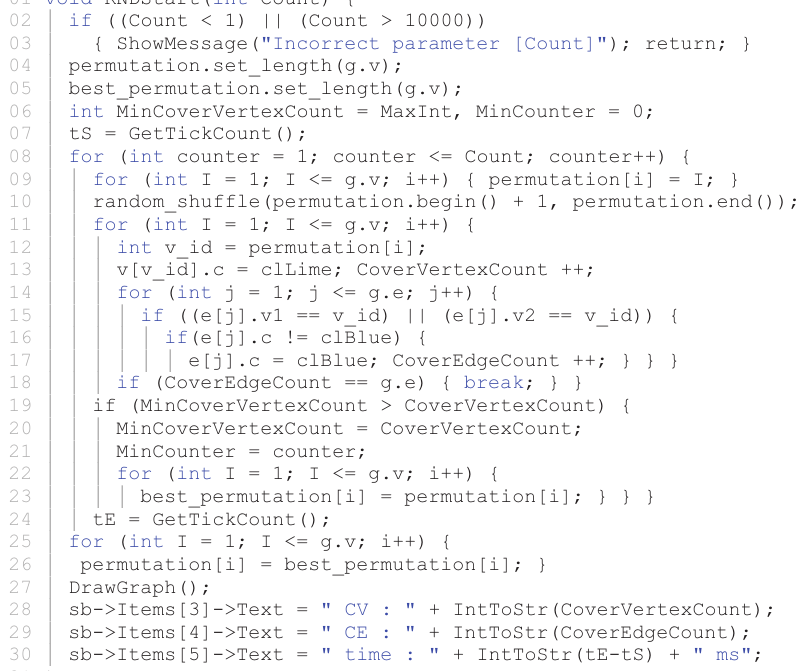
Fig. 3. Source code of the RND algorithm based on the generation of random orders of vertices One input parameter of this algorithm is the number of iterations (specified by the user) which determines how many iterations the algorithm will make to gen - erate random orders (permutations) of the vertices. For each order of vertices, the algorithm will “cover” the edges of the graph by traversing the vertices in the cur - rent order. If the number of iterations is not set correctly by the user, the RNDStart function exits. Similarly to the BTR algorithm, the RND algorithm uses the variables tE and tS to calculate the execution time of the algorithm. The for loop (lines 08–24) first sorts the elements in the permutation array from 1 to g.v, where g.v is the number of vertices in the graph (line 09). The elements in the dynamic array permutation are then shuffled randomly (line 10). In the next step, the vertices are traversed in the specified (random) order, and the edges incident to the corresponding vertices are colored, i.e., covered (lines 14–17). The conditional if statement (line 18) checks whether a solution has already been found for this arrangement of vertices. This solution must be better than the last best found. The value of the last best solution (i.e., the minimum number of vertices needed to cover the edges of the graph under the previous order) is stored in the MinCoverVertexCount variable. If the condition check on line 19 is true, then the current permutation of the vertices is stored in the best_permutation array, and the MinCoverVertexCount variable stores the value of the CoverVertexCount variable. After Count orders of vertices have been generated, the sequence of vertices where the best solution is found is transferred to the permu - tation array. The last best permutation is still stored in the best_permutation array, so its contents are transferred to the permutation array (lines 25–26). The graph is then redrawn and the values of the parameters are visualized (lines